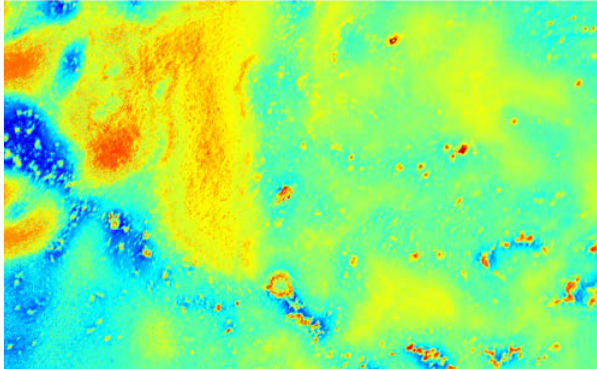
Figure 6. Second derivative at 545 nm derived after selecting UBD as preprocessing step. The live corals can be identified and match the ones visible in Fig.